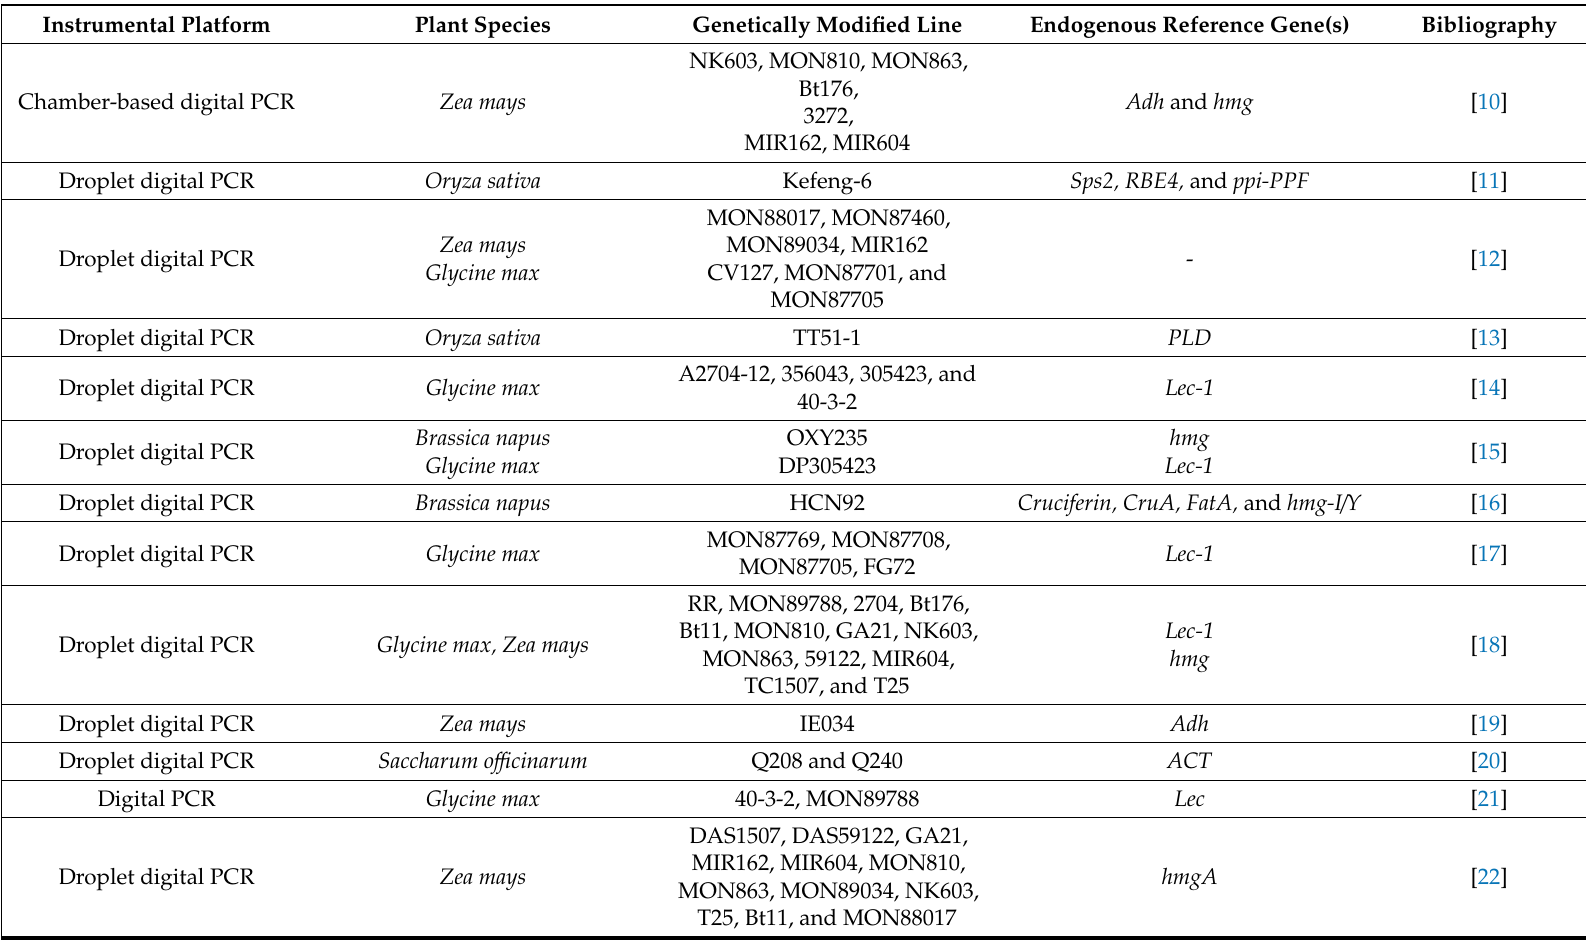
Table 1. The table shows recently developed dPCR assays aimed at identifying and quantifying genetically modified plants and at characterizing transgenic lines. Instrumental